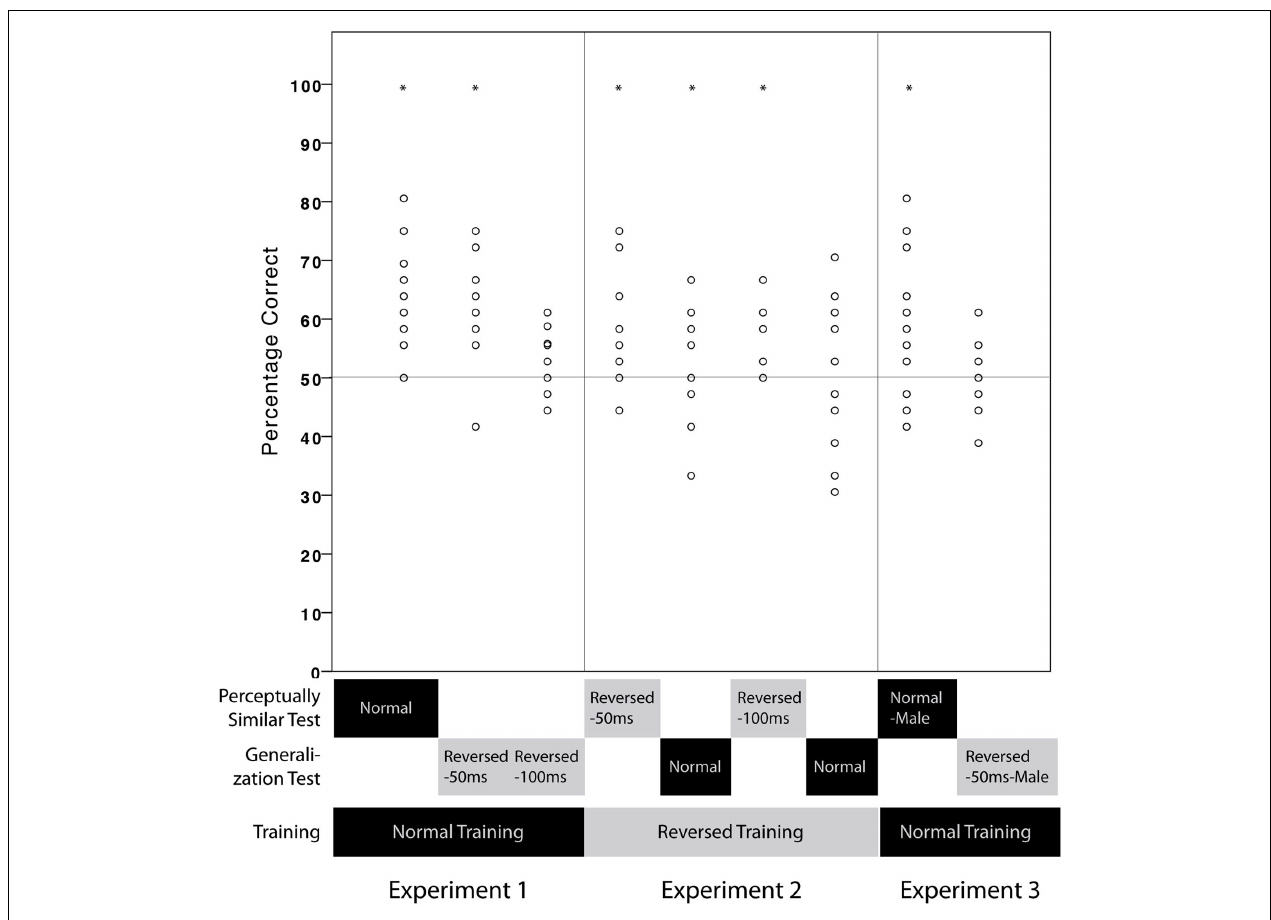
frame.Test conditions are indicated in the upper boxes: Perceptually Similar Test conditions are ones in which the training and test stimuli are perceptually similar. GeneralizationTest conditions are ones in which the training and test stimuli are perceptually